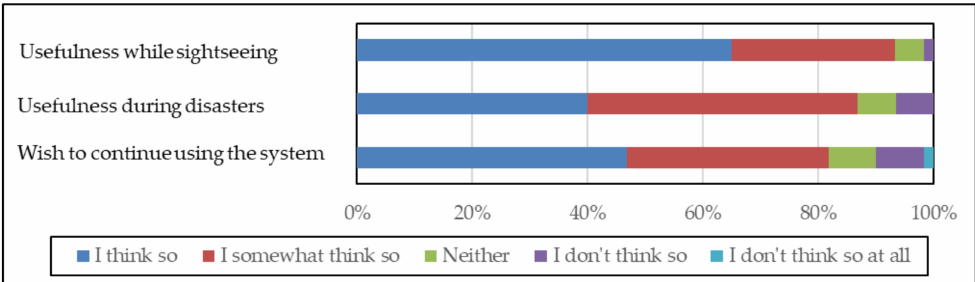
Figure 13. Evaluation results of the usefulness of the overall